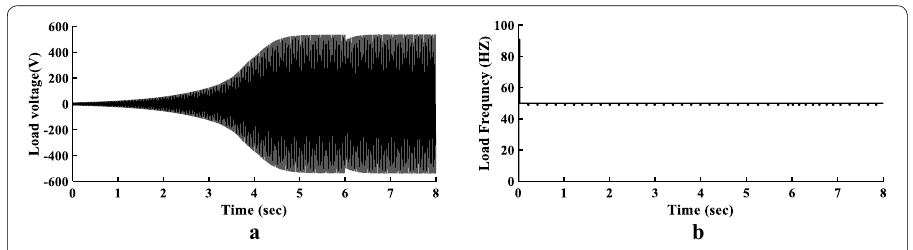
a b Fig. 11 Dynamic responses of the proposed connection at an inductive load a load voltage, b load frequency